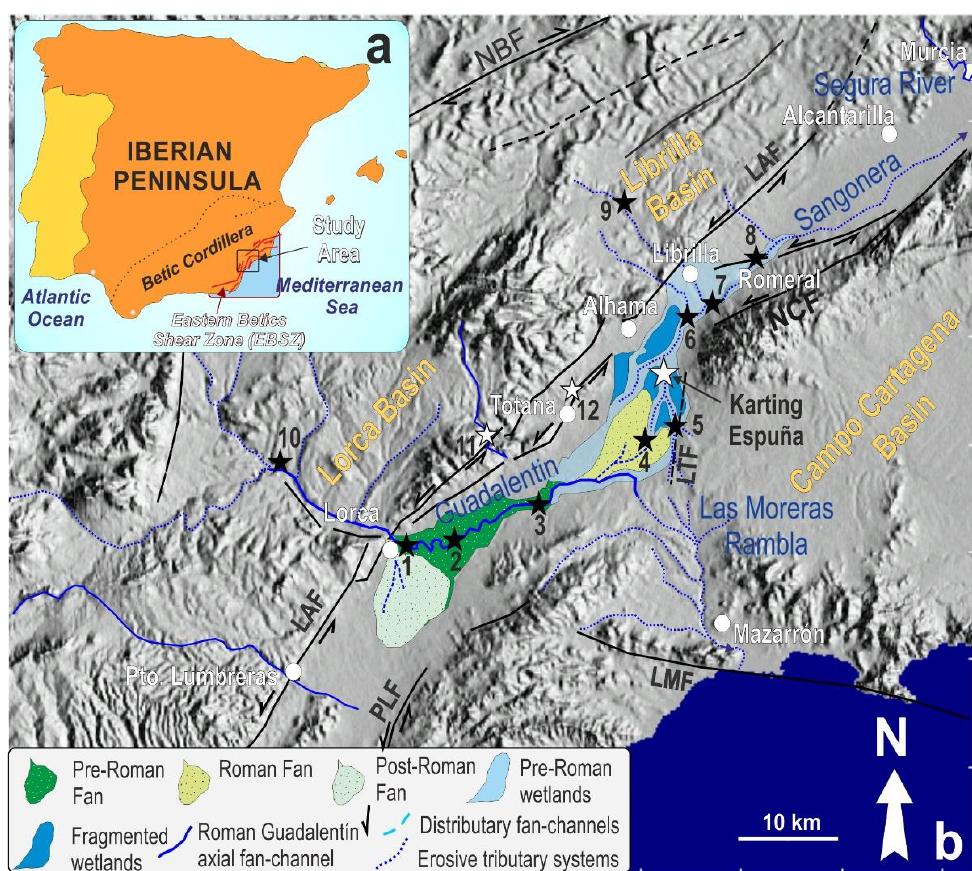
Figure 1. (a) Location of the studied area within the frame of the Betic Cordillera in the Iberian Peninsula; (b) Studied zone within the central zone of the Guadalentín Depression. Main Quaternary strike-slip faults (LAF; PLF, NCF; LMF¸LTF: see text) and different paleoenvironmental sectors defined for historical times by Silva et al. [6]. The numbered black stars indicate the location of other sections with geochronological data for the Holocene sequence: ( 1 ) Lorca, ( 2 ) La Hoya ( 3 ) Ventas del Río, ( 4 ) La Alcanara, ( 5 ) Acopios-El Rio trench sections, ( 6 ) Puente Nuevo, ( 7) Librilla, ( 8 ) El Romeral, ( 9 ) Fuente Librilla, and ( 10 ) El Estrecho-Embalse de Puentes. White stars identify the studied section (Karting Espuña), as well as important Bronze Age archaeological sites discussed in the text: ( 11 ) La Bastida de Totana and ( 12 ) La Tira del Lienzo. White circles show the location of the main localities in the studied zone